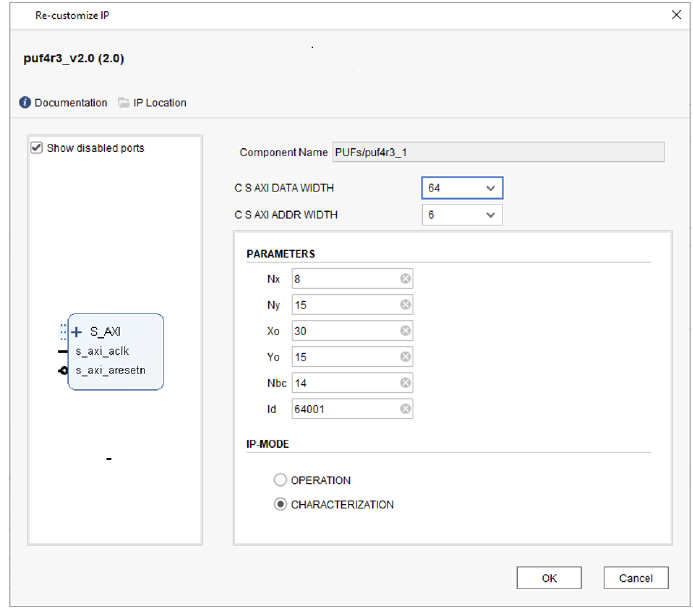
Figure 7. PUF/TRNG IP module Graphical User